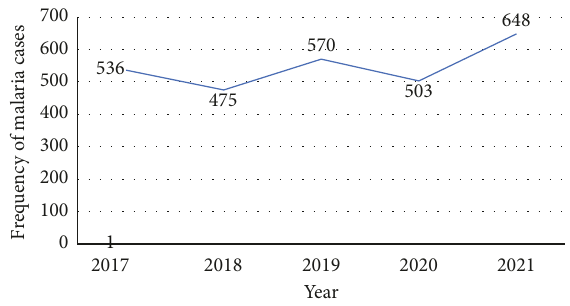
Figure 1: Trend of malaria cases by year at the selected health centers, 2021.